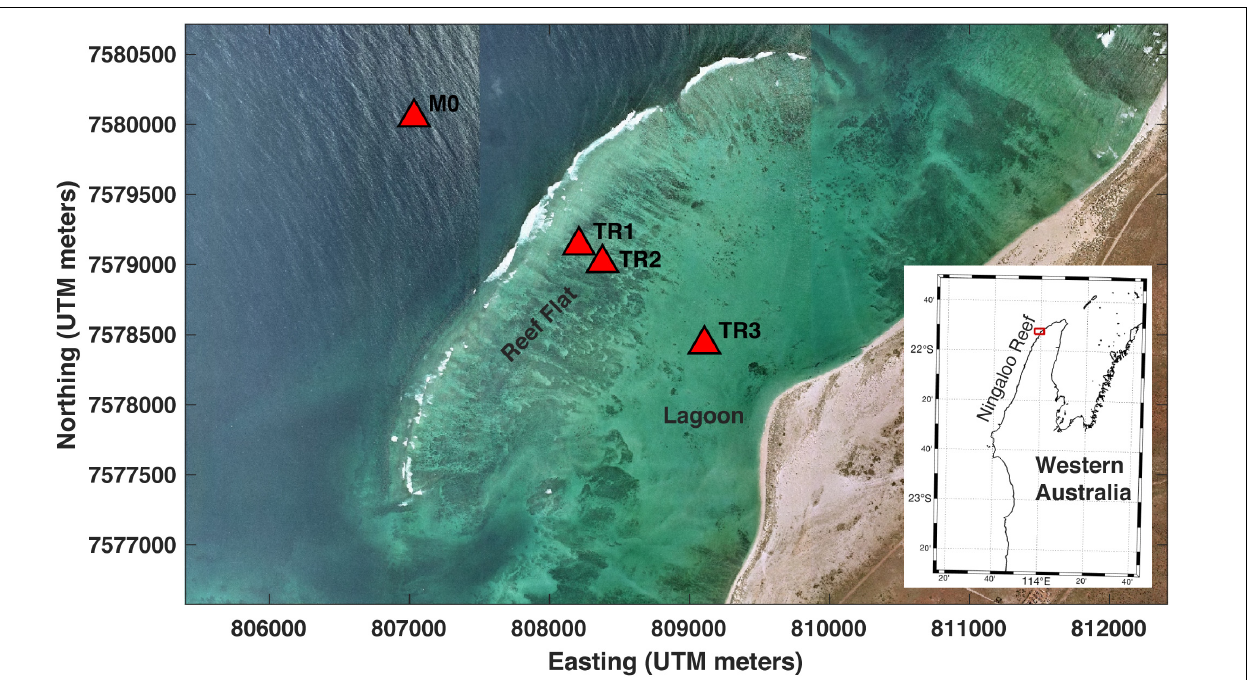
FIGURE 1 | Aerial image of the study area showing the location of the instrument packages (red triangles) used in this